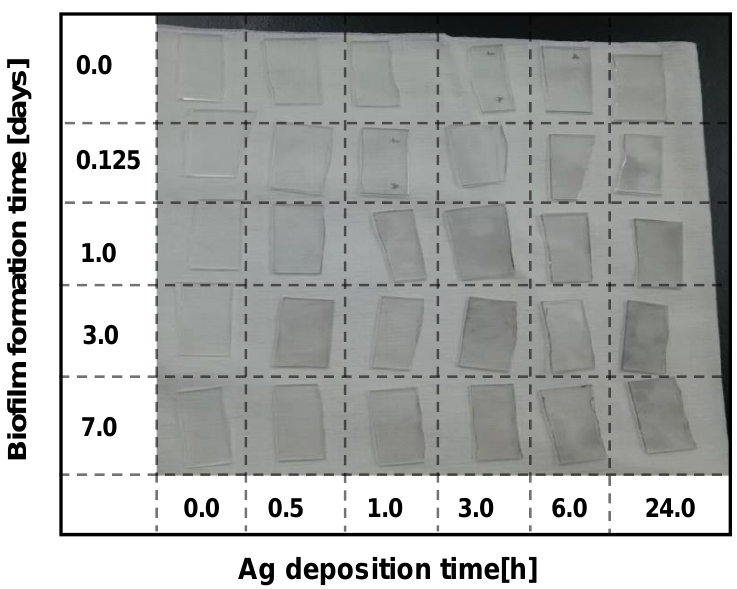
Figure 5. Variation of deposited Ag and biofilm formation with time.